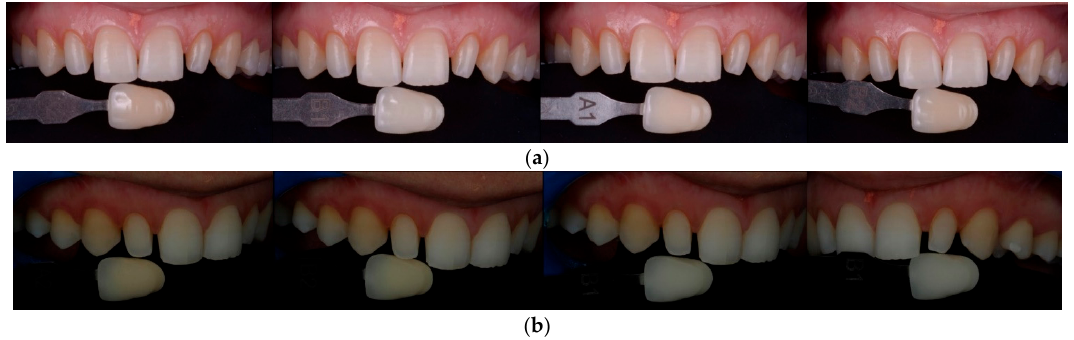
Figure 5. Color matching with: ( a ) VITA classical shade guide and ( b ) polar_eyes cross-polarization filter (Bio-Emulation™, Freiburg im Breisgau, Germany).